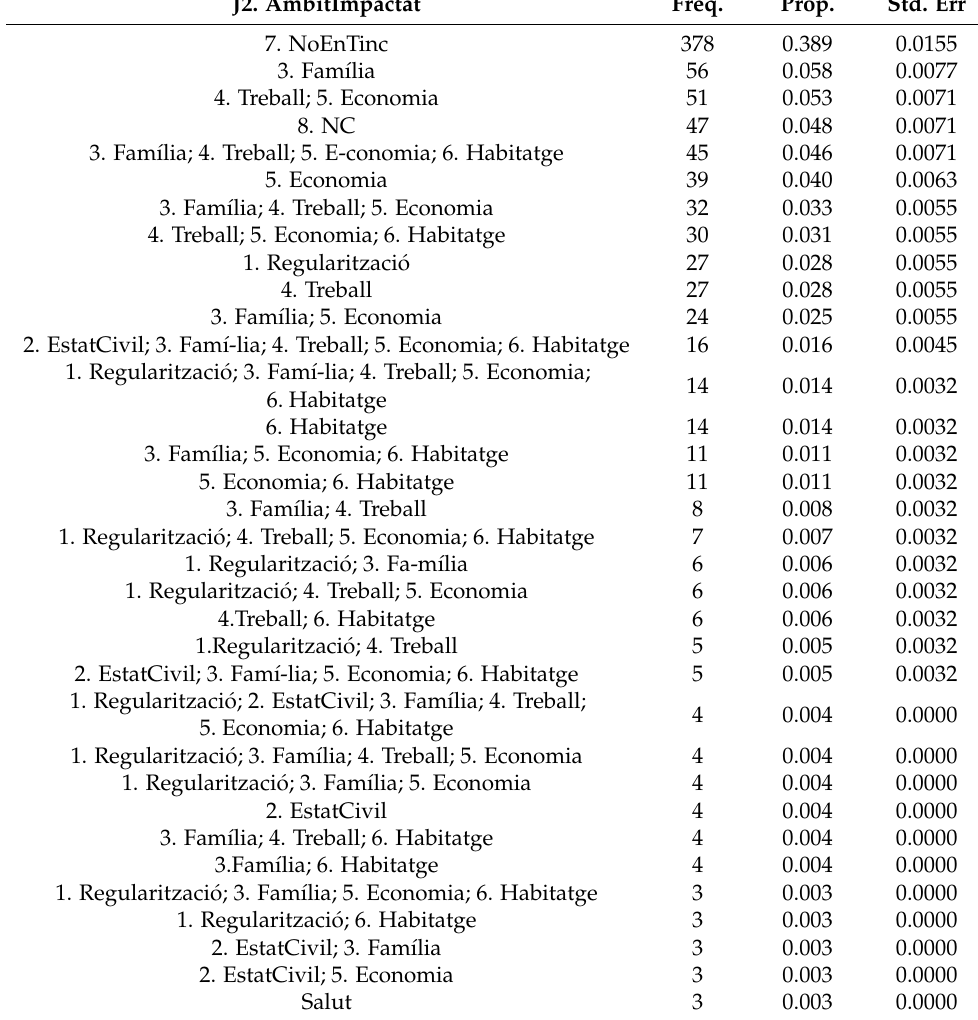
Table 4. Multivalued frequency